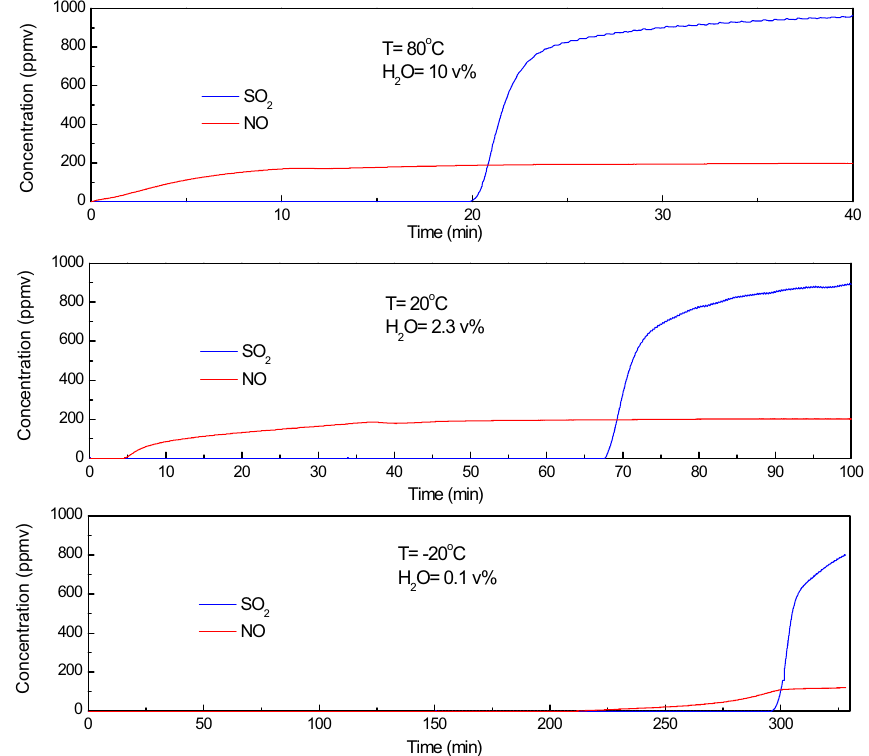
Figure 5. Breakthrough curves of SO 2 (blue) and NO (red) adsorption at 80, 20 and − 20 ℃ (Simulated flue gas: SO 2 = 1000 ppmv, NO = 200 ppmv, O 2 = 6 vol.%, CO 2 = 12 vol.%, space velocity = 5000 h −1